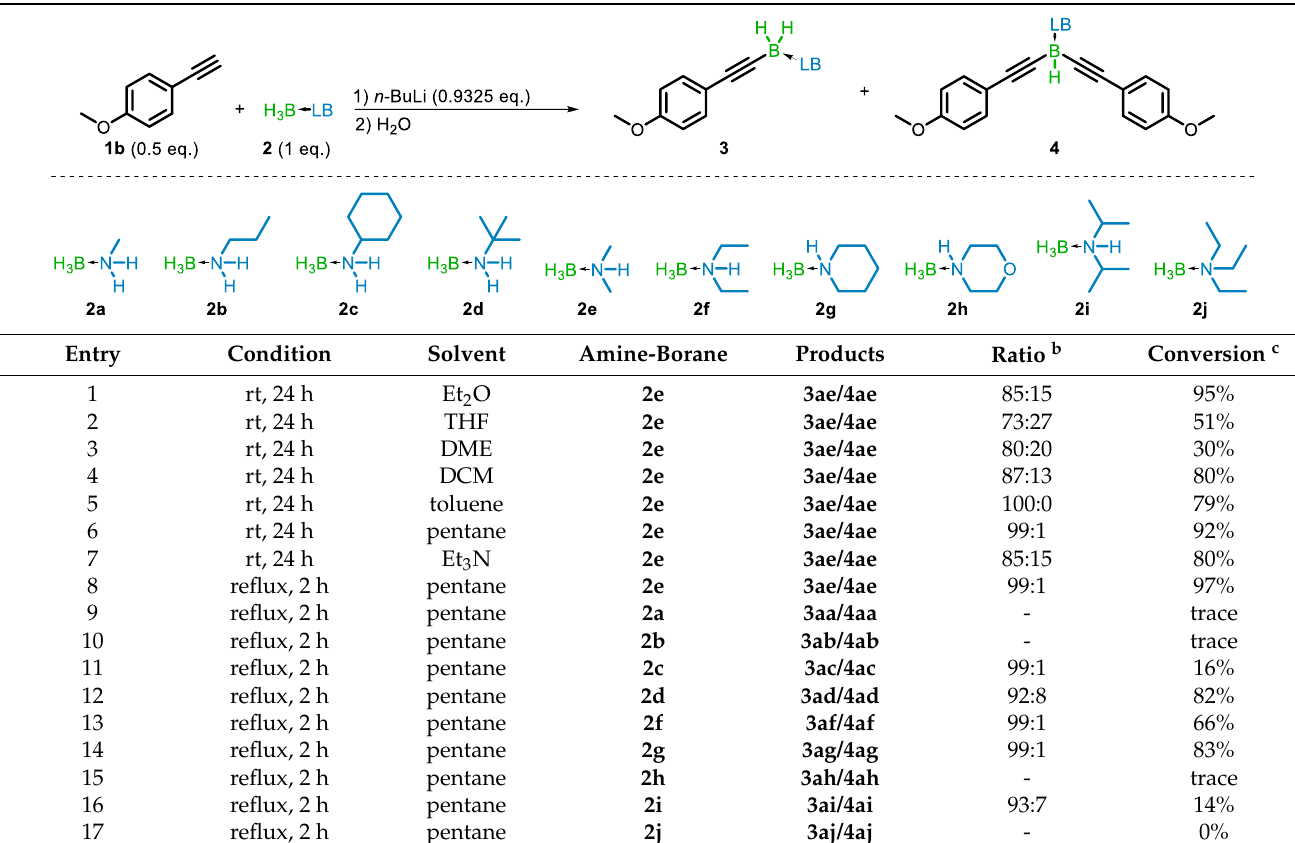
Table 1. Optimization of the reaction solvent and amine-borane a